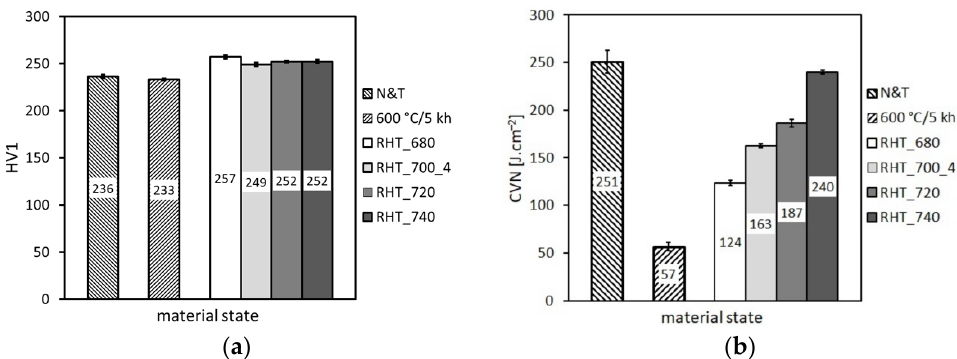
Figure 17. The effect of various annealing temperatures of individual rejuvenation heat treatments with most efficient heating up and cooling down conditions on ( a ) hardness and ( b ) impact toughness.